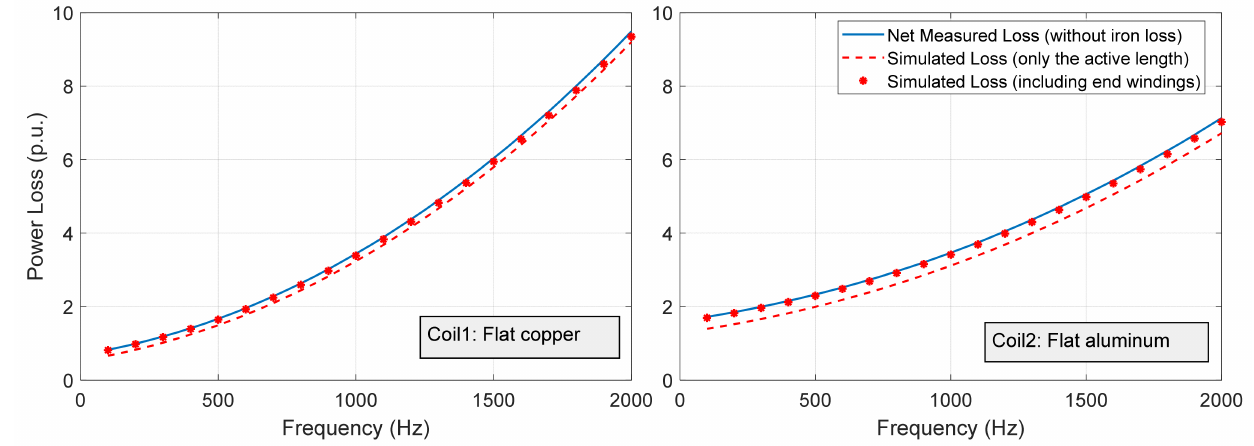
Figure 13. Comparison between simulations and measurements for both test samples.